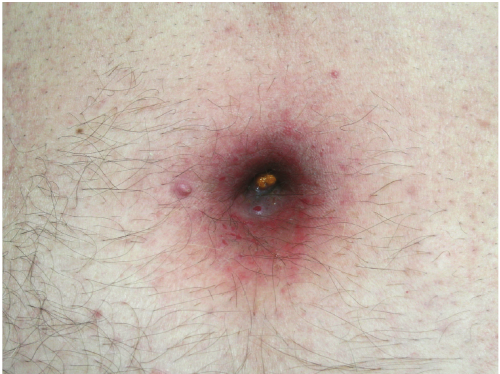
Figure 1: The inflamed and macerated umbilicus and periumbilical skin with fecal material into the umbilical pit.